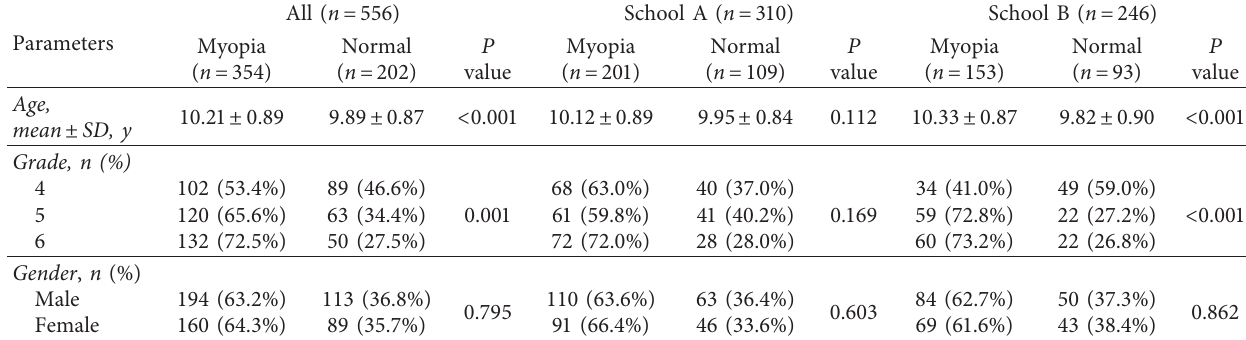
Table 1: Characteristics of students in two elementary